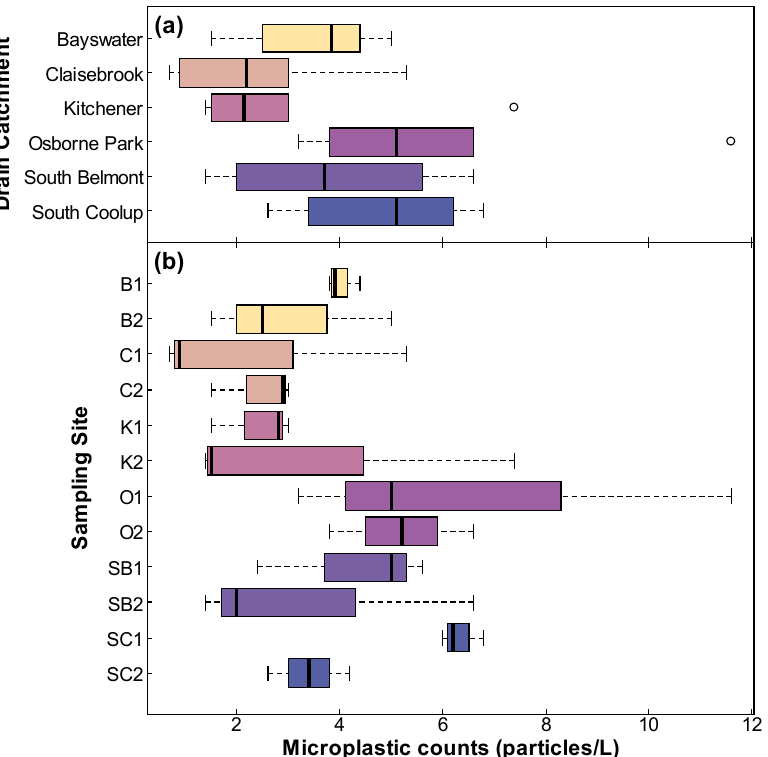
Figure 4. Comparison of microplastic concentrations ( a ) in each catchment and ( b ) at each site. The bar colours are simply to provide a visual match between catchments and sites in each catchment.